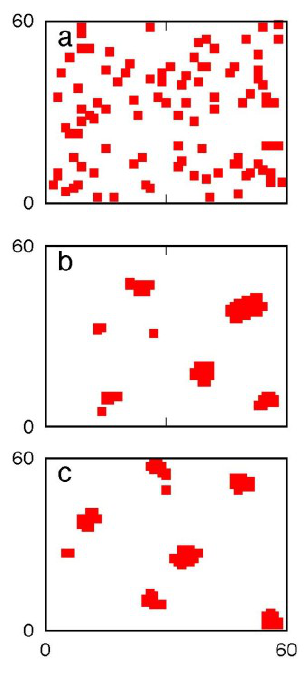
Figure 14. DISC (death inducing signaling complex) clustering for three different values of the DISC clustering energy parameter: E molecules (that bind death-receptor ligand complex to generate DISC) are shown on the cell surface of 60 × 60 lattice sites (1.2 μm × 1.2 μm). Pon = 1 and Poff = 10 −3 are used in the simulations. Representative single cell data are shown after 10 7 MC